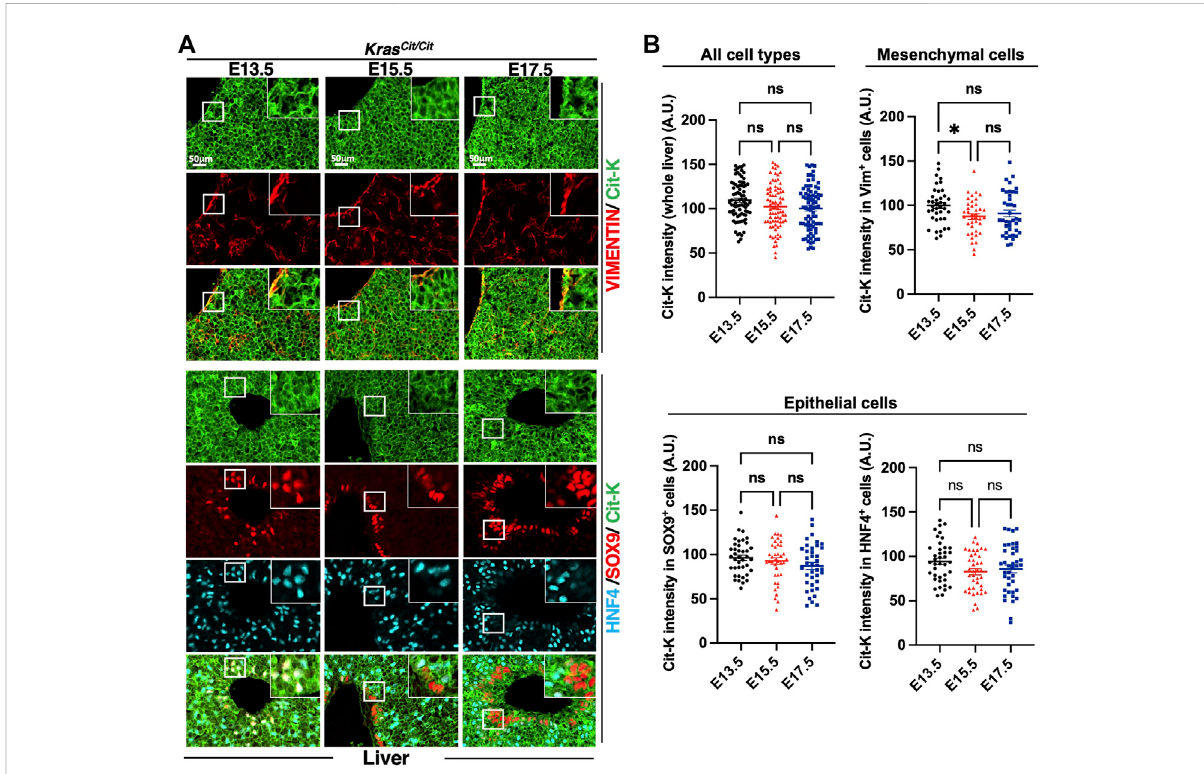
Cit-K is expressed in embryonic liver. (A) Immunolabeling for Cit-K, VIMENTIN (VIM), SRY-box transcription factor 9 (SOX9), and Hepatocyte nuclear factor 4 (HNF4) performed on liver sections of Kras Cit/Cit embryos at E13.5, E15.5 and E17.5. (B) Quanti fi cation by FIJI software of Cit-K signal intensity in the whole liver, mesenchymal (VIM + ) cells, and two types of liver epithelial cells (SOX9 + or HNF4 + cells). One dot represents the mean of threemeasuresofsignalintensityinonecell.Dataarerepresentedasmean+/-SEMof80or40cells(n=4embryos).Statisticalsigni fi cancewas tested by Student ’ s t -test. *, p < 0.05; ns, not signi fi cant. A.U. arbitrary